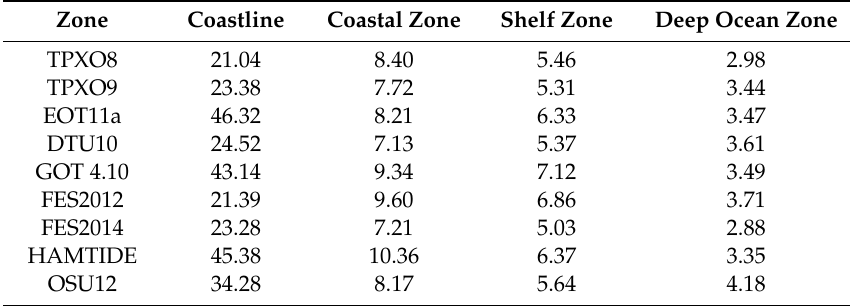
Table 5. The mean RSS values (in cm) for all 8 major tidal constants for the tidal models over coastline (CL), coastal zone (CZ), shelf zone (SZ) and deep ocean zone